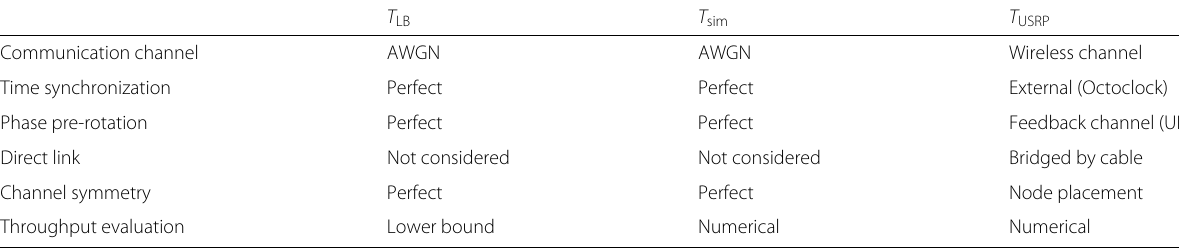
Table 2 Summary of assumptions in the uncoded system analysis T LB T sim T USRP